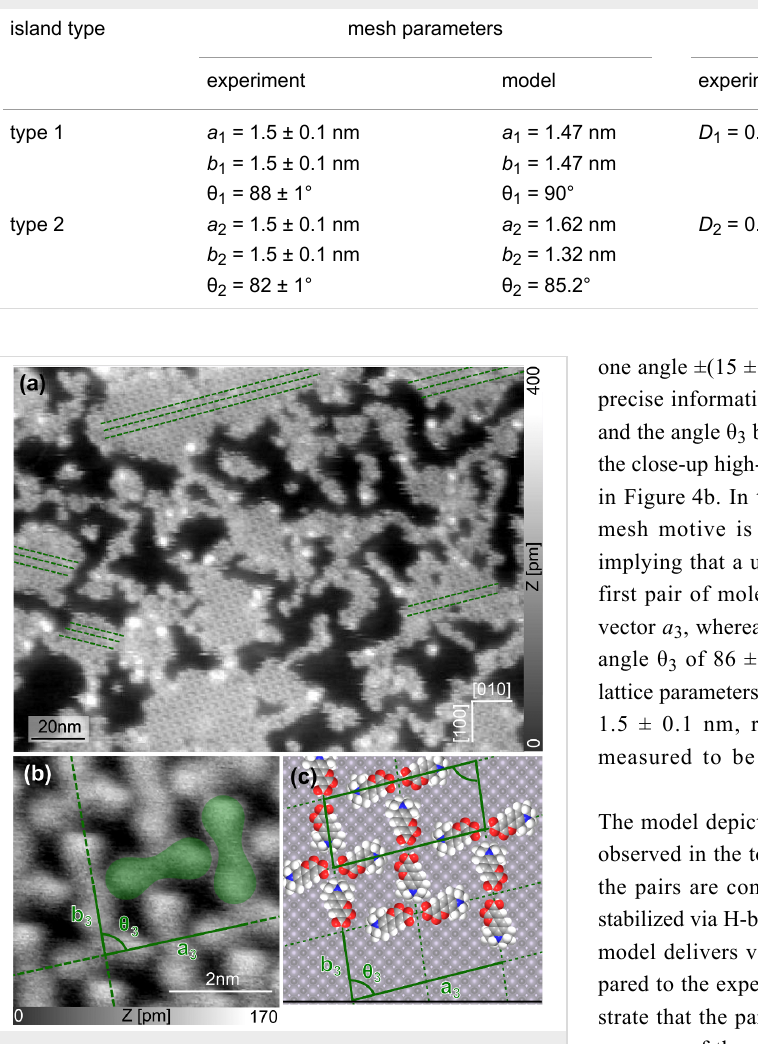
Figure 4: (a) Large-scale topographic image showing that C343 mole- cules form islands on the surface of NiO(001). (b) Close-up topo- graphic image taken on top of one of these islands. One unit cell corre- sponds to four molecules arranged in two different pairs of molecules shown in green. (c) Corresponding model reproducing the mesh motive (scan parameters: = 7 nm, Δ f 1 = − 7